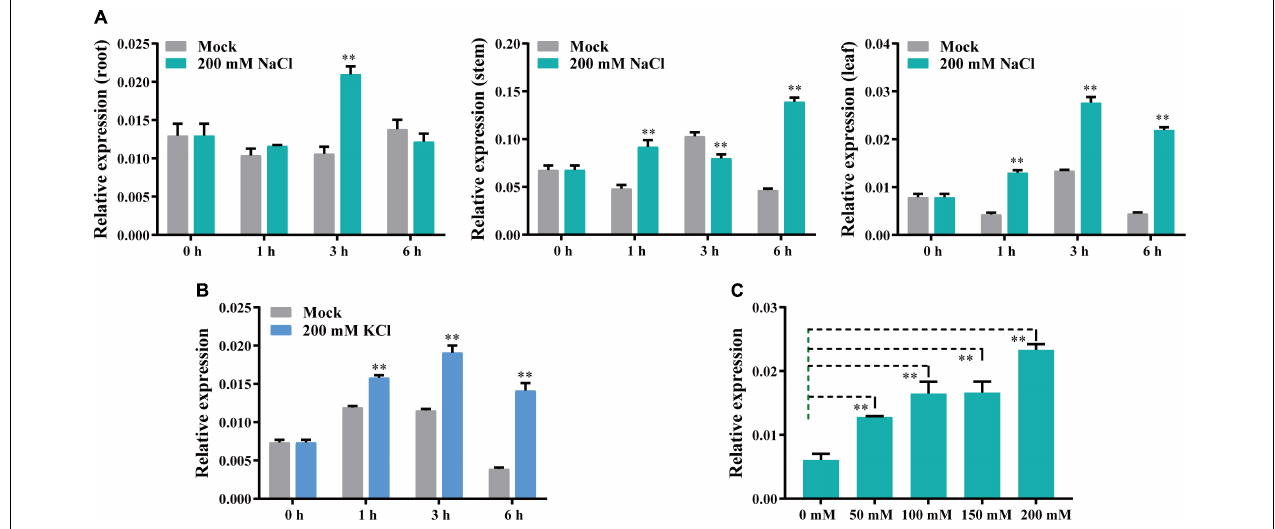
FIGURE 4 | GhCLCg-1 expression profiles in salt-treated upland cotton plants. GhCLCg-1 expression patterns in the roots, stems, and leaves of plants treated with 200 mM NaCl for 0, 1, 3, and 6 h (A) or in the leaves of plants treated with 200 mM KCl for 0, 1, 3, and 6 h (B) . (C) GhCLCg-1 expression patterns in the leaves of plants treated for 6 h with different NaCl concentrations (0, 50, 100, 150, and 200 mM). The 2 − (cid:49) CT method was used to calculate relative expression levels. Error bars indicate the standard deviation (SD) of three biological replicates ( ∗∗ p < 0.01; t